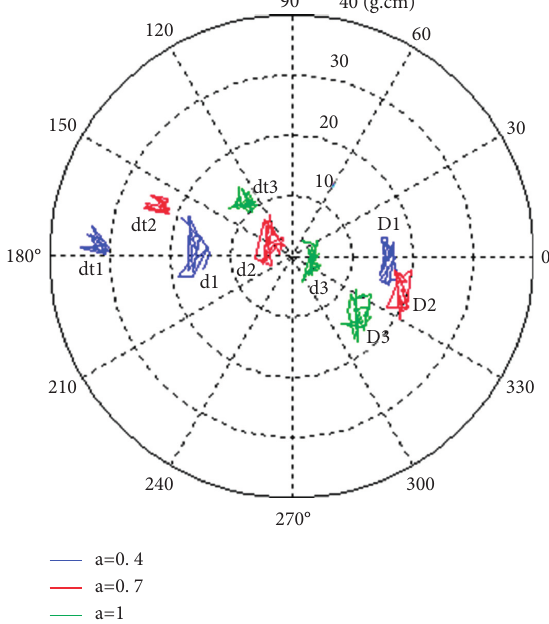
Figure 9: The iterative correcting effect with variable weight re- moving